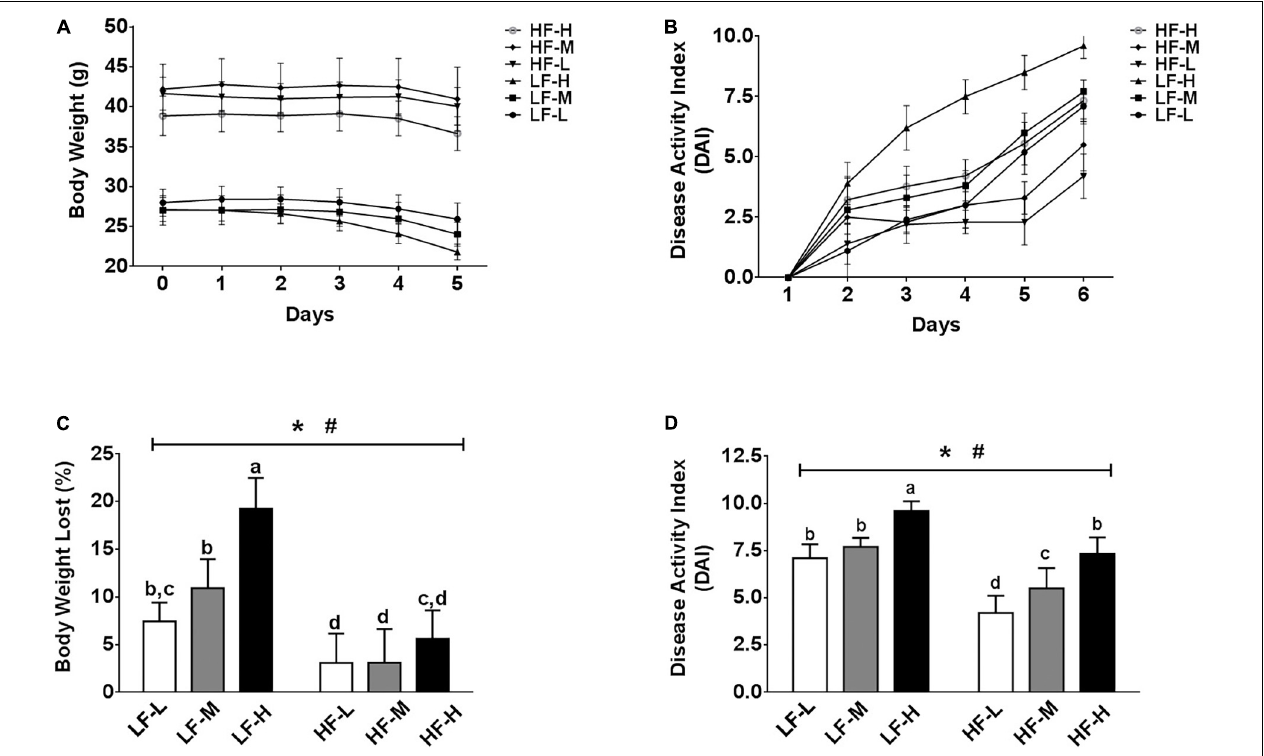
FIGURE 2 | Body physiological conditions and DAI scores. (A) Change curves of body weight and (B) DAI scores during DSS-induction. Comparison of (C) body weights and (D) DAI scores at the end of DSS-induction. Bars with the same letter indicate a non-significant difference ( P > 0.05). Asterisk indicates a significant difference between the high fat diet groups and low fat diet groups; # indicates a significant difference between the mice from groups fed with the diets of different LA/ALA